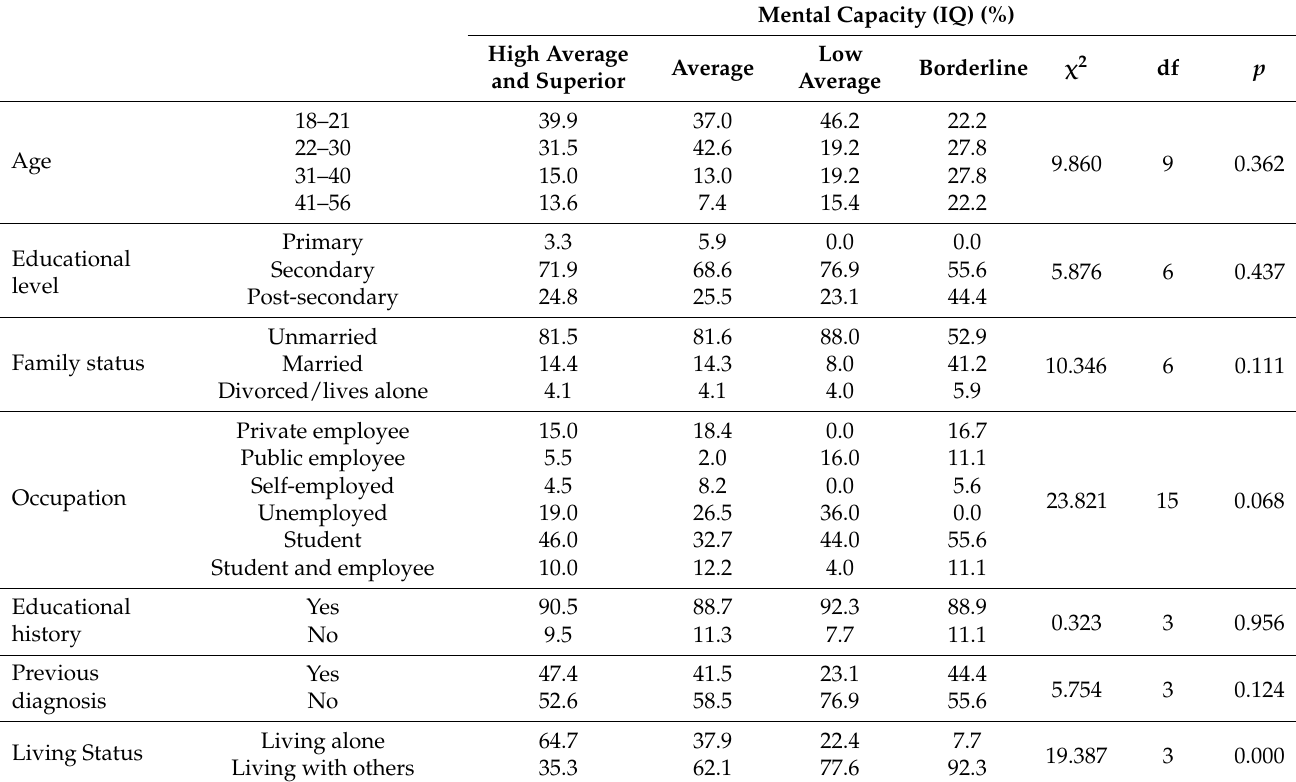
Table A1. Relationship of the Mental Capacity (IQ) of the assessed adults with the other